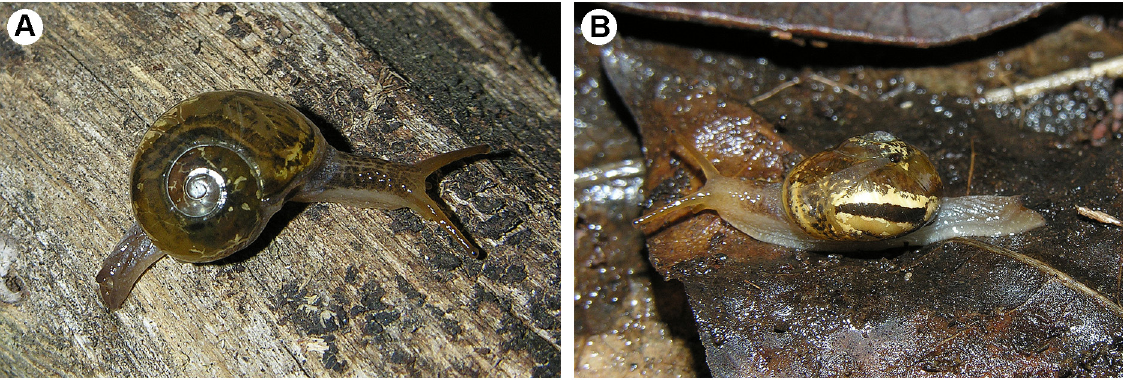
Fig. 5. Ptilototheca soutpansbergensis gen. et sp. nov., living animals, Entabeni Forest, Soutpansberg, Limpopo. A . Darkly pigmented individual, shell diameter 8.4 mm (paratype, NMSA P0186/T4063). B . Paler individual showing contrasting pigmentation overlying the renal area, shell diameter 8.0 mm (paratype, NMSA